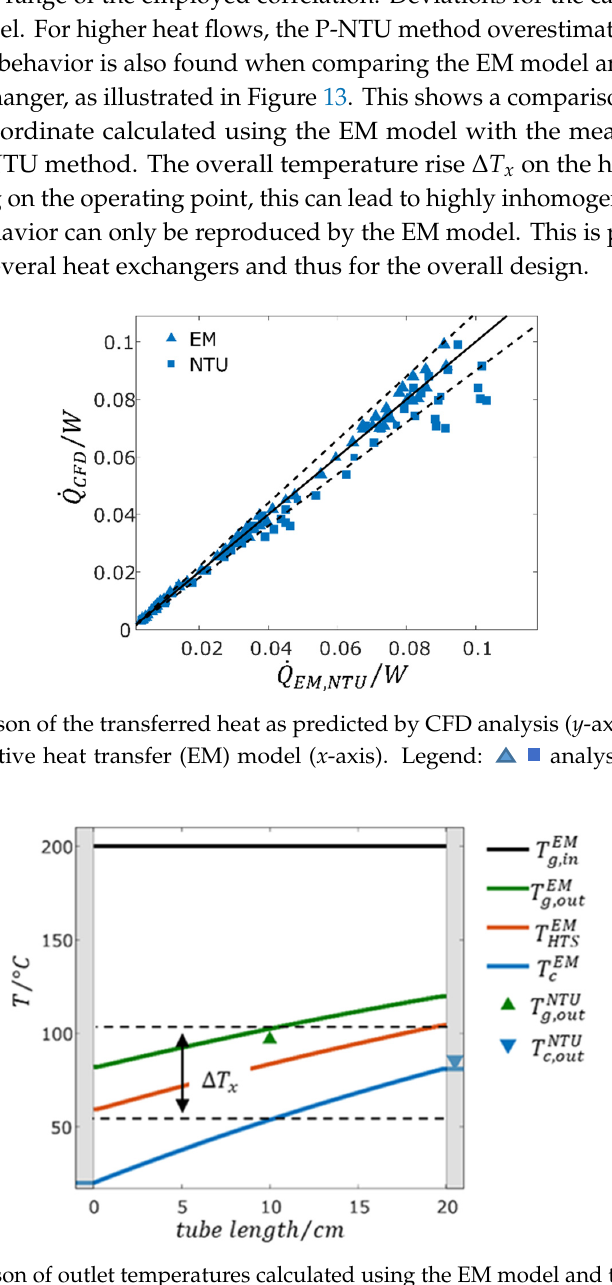
Figure 13. Comparison of outlet temperatures calculated using the EM model and the P-NTU method. The dotted lines indicate the overall temperature increase ∆ T x of the heat transfer surface along the tube coordinate calculated by the EM (effective heat transfer) model.